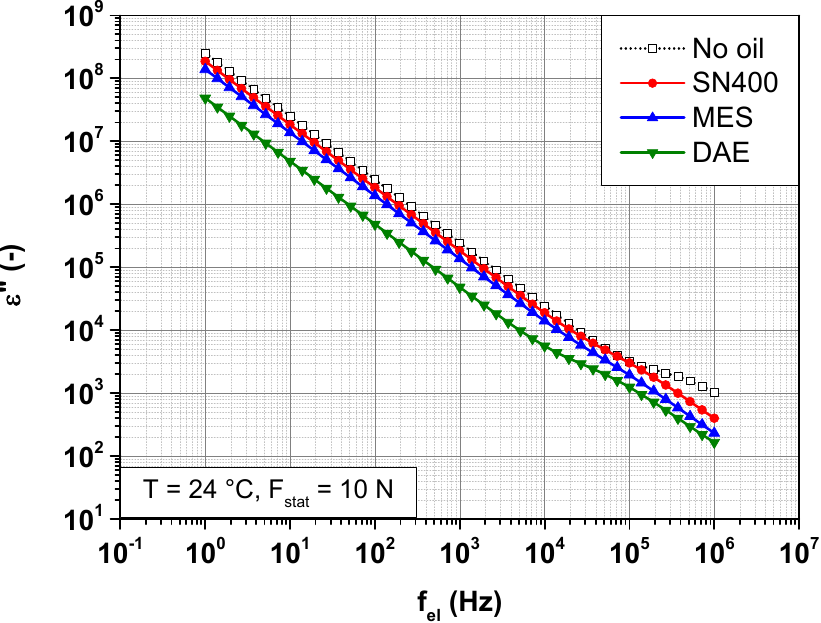
Figure 7. Frequency ‐ dependent change in the imaginary part of the permittivity 𝜀 (cid:4593)(cid:4593) of SBR samples with different plasticizers at 24 °C under a static force of 10 N.